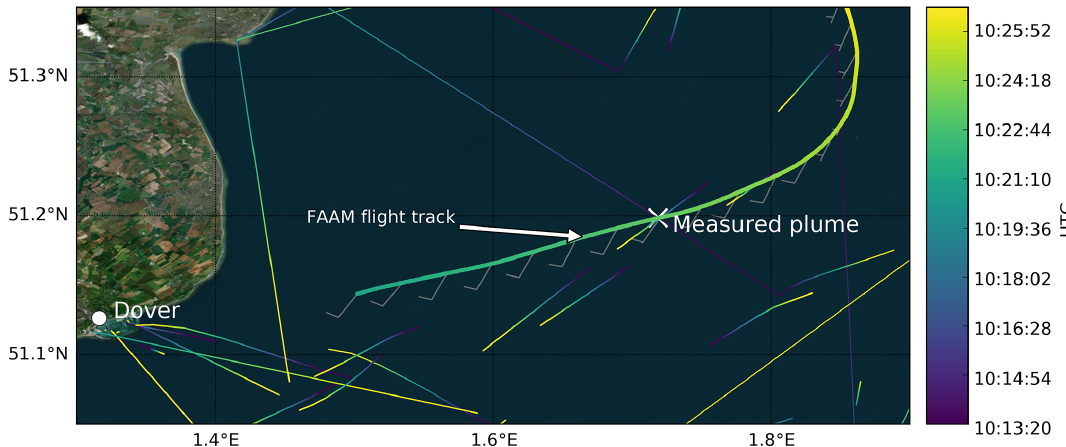
Figure 9. Flight track of FAAM BAe-146 (thick coloured line) during flight C017 at the beginning of the level run at ∼ 40ma.m.s.l. where a large ship plume was measured (indicated with a white cross). Wind speed and direction measured by FAAM BAe-146 are shown by the wind barbs. The trajectories of all the ships > 10kt are shown by thin coloured lines with the colour scale denoting time. The base map was created using the World Imagery maps in ArcGIS ® software by Esri. ArcGIS ® and ArcMap™ are the intellectual property of Esri and are used herein under license. Copyright ©Esri. All rights reserved. For more information about Esri ® software, please visit https://www.esri.com (last access: March 2020).